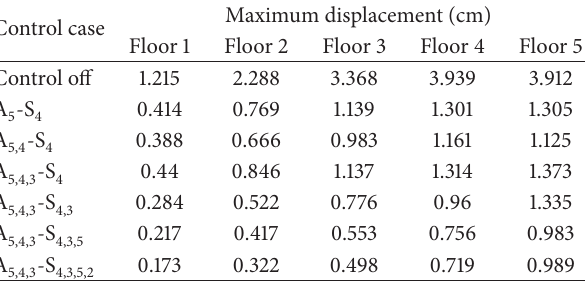
Table 5: The maximum structural displacements for the harmonic load.